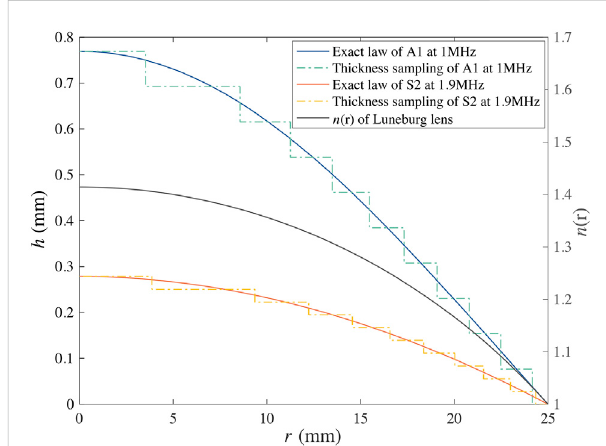
FIGURE 3 The variations of the refractive index and the thickness of the A1- wave-based Luneburg lens and S2-wave-based Luneburg lens along the radius direction. The black curve is the refractive index of the Luneburg lens. Blue and orange curves are the theoretical thickness pro fi les of the A1-wave-based Luneburg lens at 1 MHz and the S2-wave-based Luneburg lens at 1.9 MHz, respectively, and the discretized pro fi lesare represented by thegreen and yellow